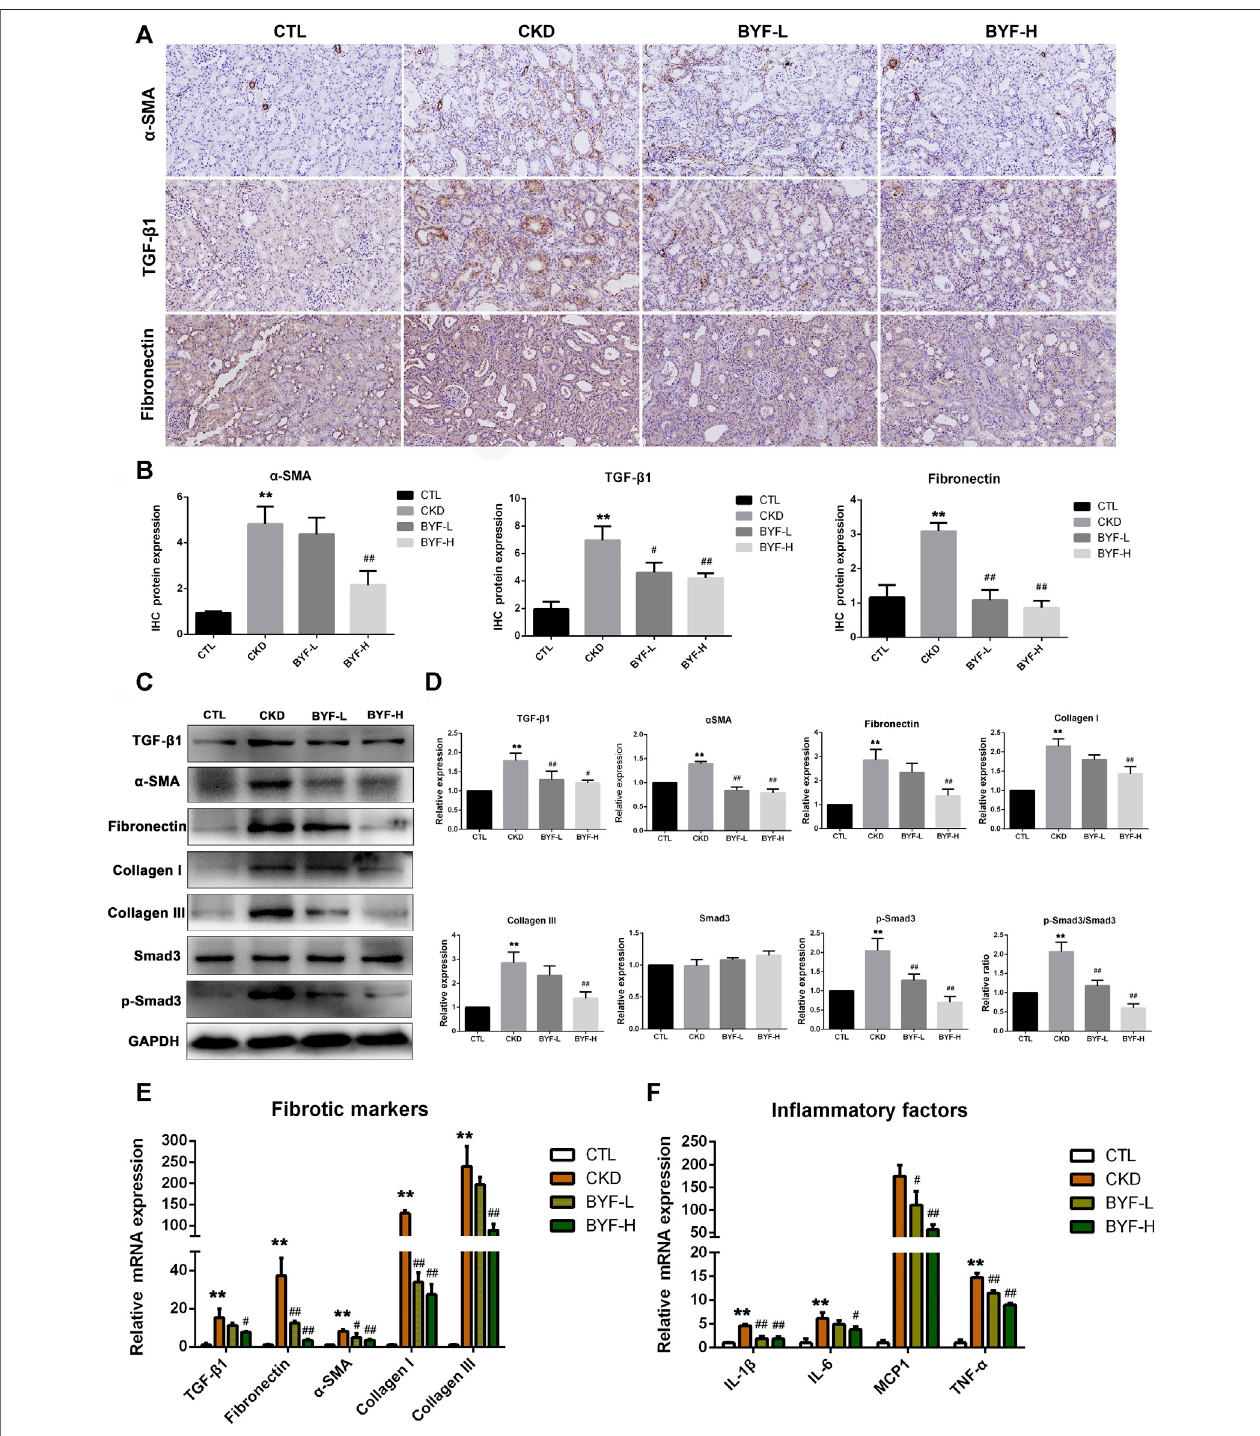
FIGURE 4 | BYF reduces fi brotic and in fl ammatory markers expression levels in the kidney of adenine-induced CKD rats. α -SMA, TGF- β 1, and Fibronectin immunohistochemical staining representative micrographs (A) and quantitative analysis (B) . TGF- β 1, Fibronectin, α -SMA, Collagen I and III, and p-Smad3 WB va α lidation (C) and quantitative analysis (D) . qPCR validation of fi brotic markers (E) and proin fl ammatory factors (F) in indicated groups. Scale bar (cid:1) 100 μ m. All values are presented as means ± SD. n (cid:1) 3 rats per group. * p < 0.05 and ** p < 0.01 vs. the CTL group; # p < 0.05 and ## p < 0.01 vs. the CKD group.